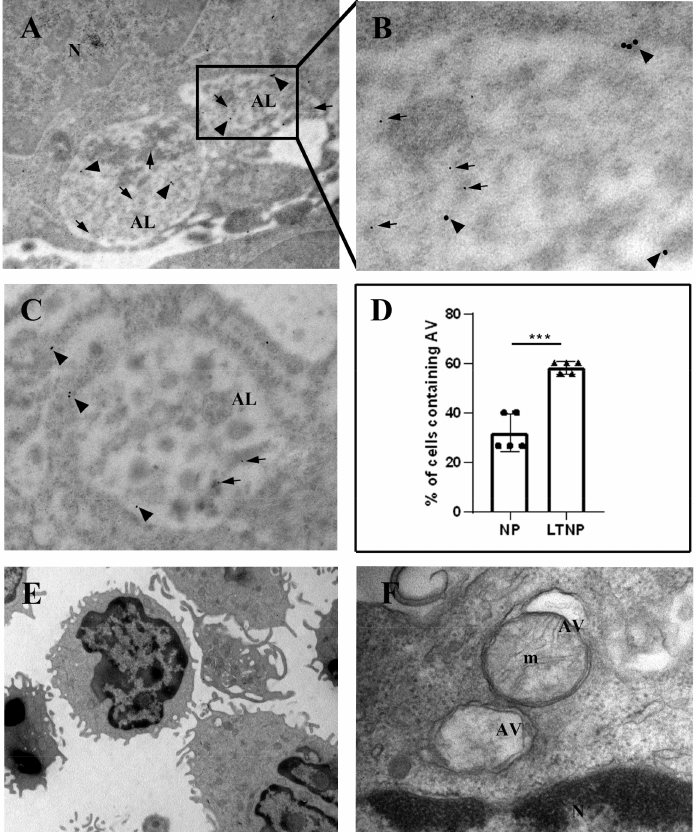
Figure 5. Immuno-electron microscopy and ultrastructural analysis of PBMC from HIV-1-infected LTNP patients. ( A – D ) PBMC from 5 LTNP (Patients No. 1, 3, 6, 8, and 10) were subjected to immunogold analysis. HIV-1 Nef (arrows) and TRIM5 α (arrowheads) immunolabelling colocalized in ALs. The images show autolysosomes (ALs) containing undigested material, in which gold particles labelling HIV-1 Nef (arrows) and TRIM5 α (arrowheads) are present. ( B ) Higher magnification of the boxed area presented in Figure 4A. ( C ) AL is visible, containing gold particles of 5 and 15 nm. ( D ) Quantitative analysis of the percentage of cells containing AV in 5 NP and 5 LTNP. In the graph, data are reported as scatter plots with mean values ± s.d. *** p < 0.001. ( E ) Ultrastructural analysis of PBMC from HIV-1 controllers. ( F ) AVs surrounded by double membranes. AL, autolysosome; AV, autophagic vacuole; N, nucleus; m, mitochondria. NP, HIV-1-infected normal progressor patients; LTNP, long-term nonprogressors. Original magnifications: A, 20,000 × , B, 85,000 × ; C, 50,000 × ; E, 7000 × ; F, 50,000 ×